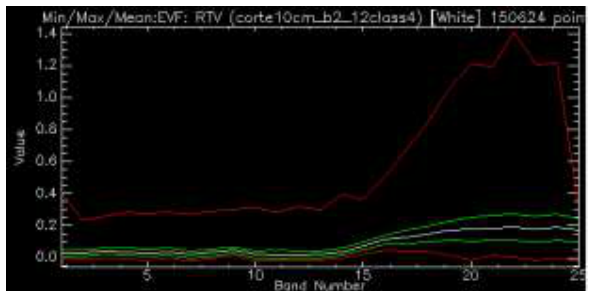
Figure 12. Graphical representation of maximum, minimum (red lines) and mean (white) values of all wavelengths of the sample which represent shadow pixels in the LRcube Lower differences between maximum and minimum values are on 519.9 nm and on the 840.3 nm, as well as to the LRcube. All statistics values are presented in the